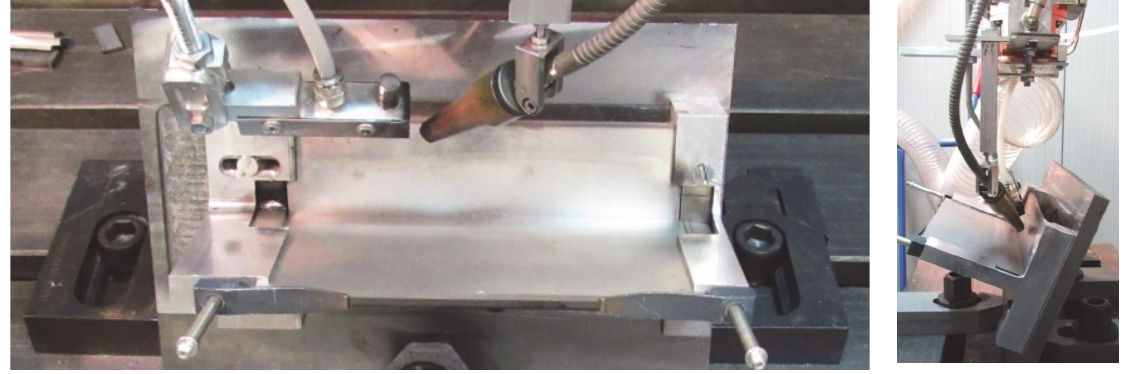
Figure 3: Protection and clamping system